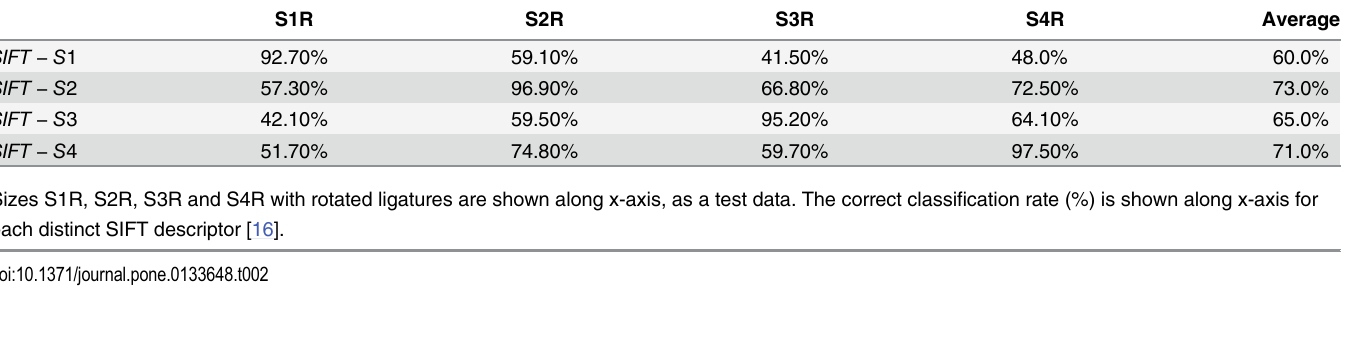
Table 2. Confusion matrix.